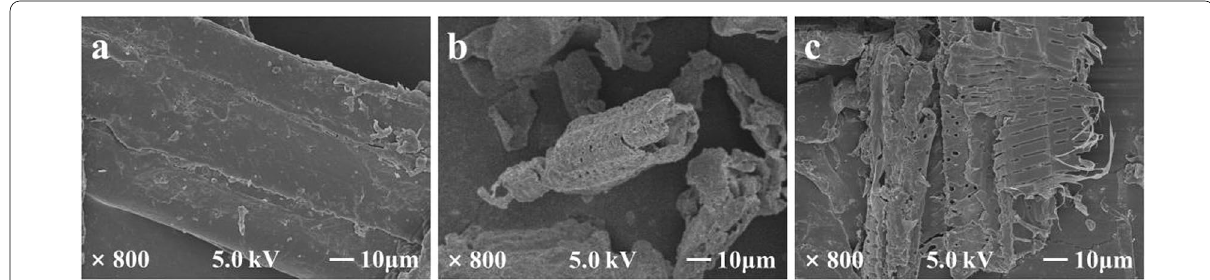
Fig. 3 SEM of SCB before and after pretreatment. a Raw SCB, b 175 °C-30 min, c 155 °C-1 MPa-20